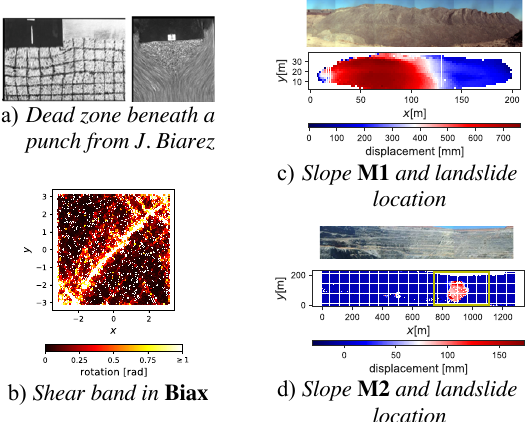
Fig. 1. Kinematics at failure across